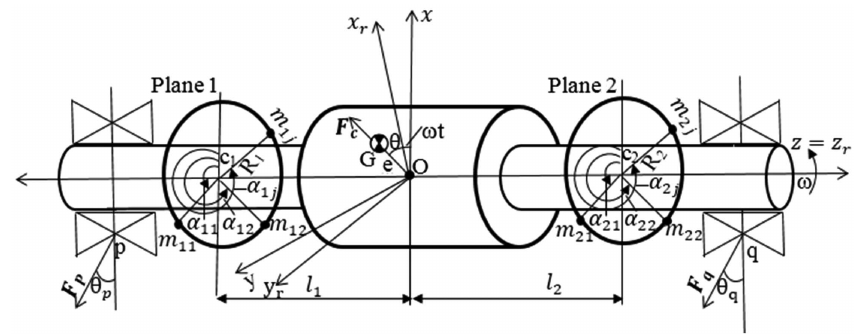
Figure 12: Balancing Model of Rigid Threshing